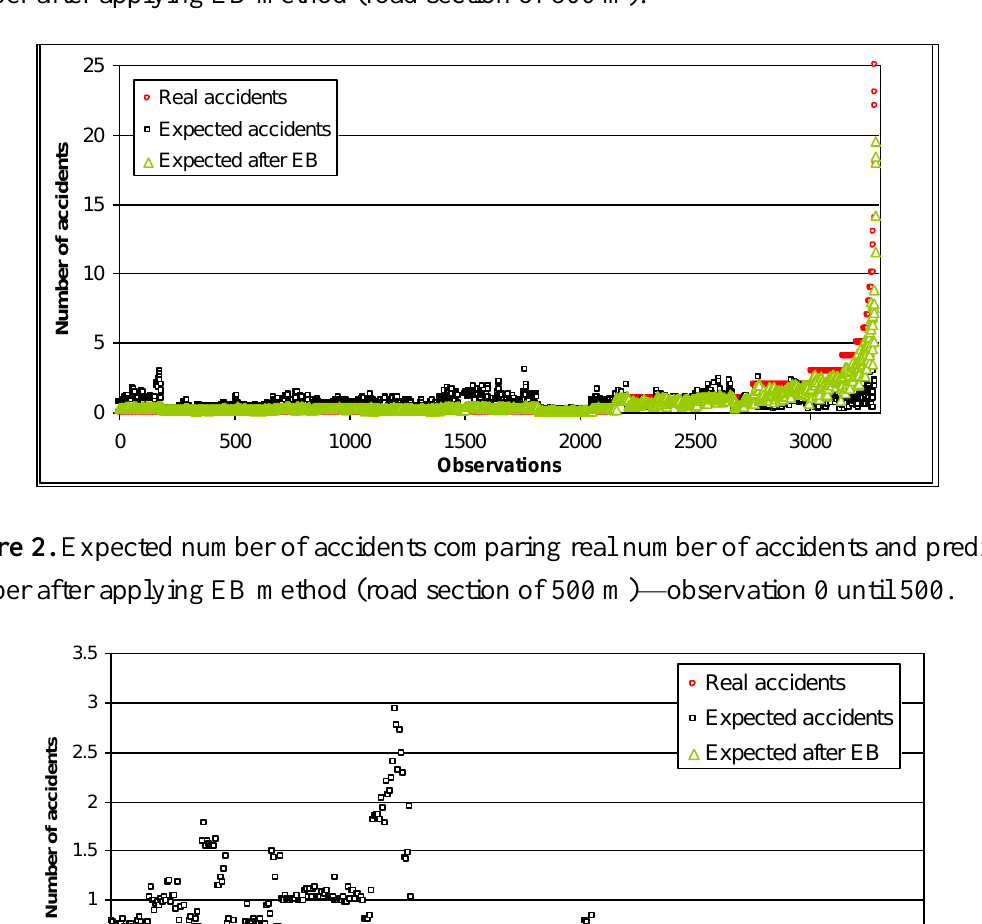
number after applying EB method (road section of 500 m).